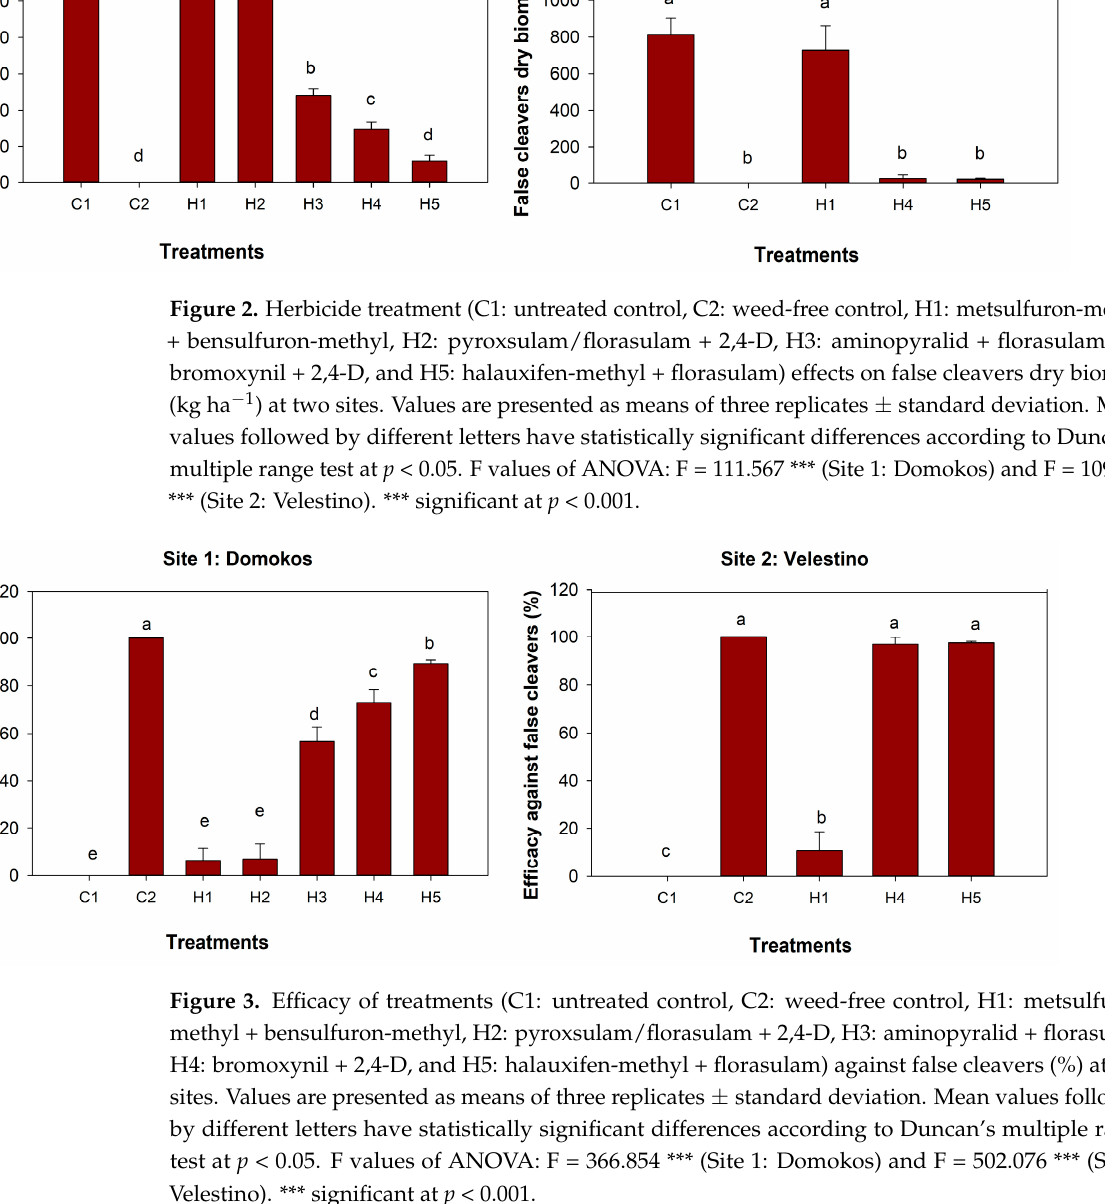
Figure 3. Efficacy of treatments (C1: untreated control, C2: weed-free control, H1: metsulfuron-me- thyl + bensulfuron-methyl, H2: pyroxsulam/florasulam + 2,4-D, H3: aminopyralid + florasulam, H4: bromoxynil + 2,4-D, and H5: halauxifen-methyl + florasulam) against false cleavers (%) at two sites. Values are presented as means of three replicates ± standard deviation. Mean values followed by different letters have statistically significant differences according to Duncan’s multiple range test at p < 0.05. F values of ANOVA: F = 366.854 *** (Site 1: Domokos) and F = 502.076 *** (Site 2: Veles- tino). *** significant at p < 0.001.